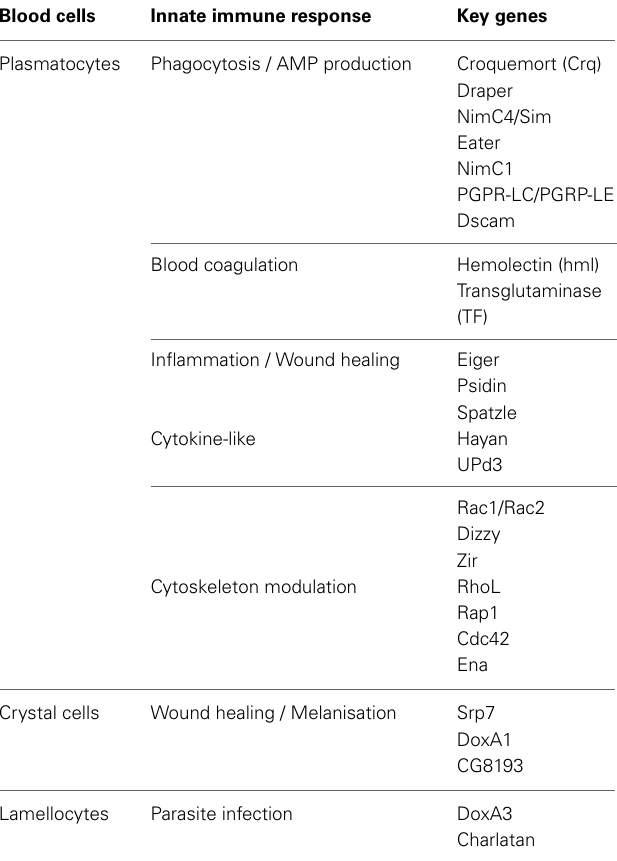
Table 1 | Key genes involved in innate immunity, inflammatory responses and wound healing in Drosophila